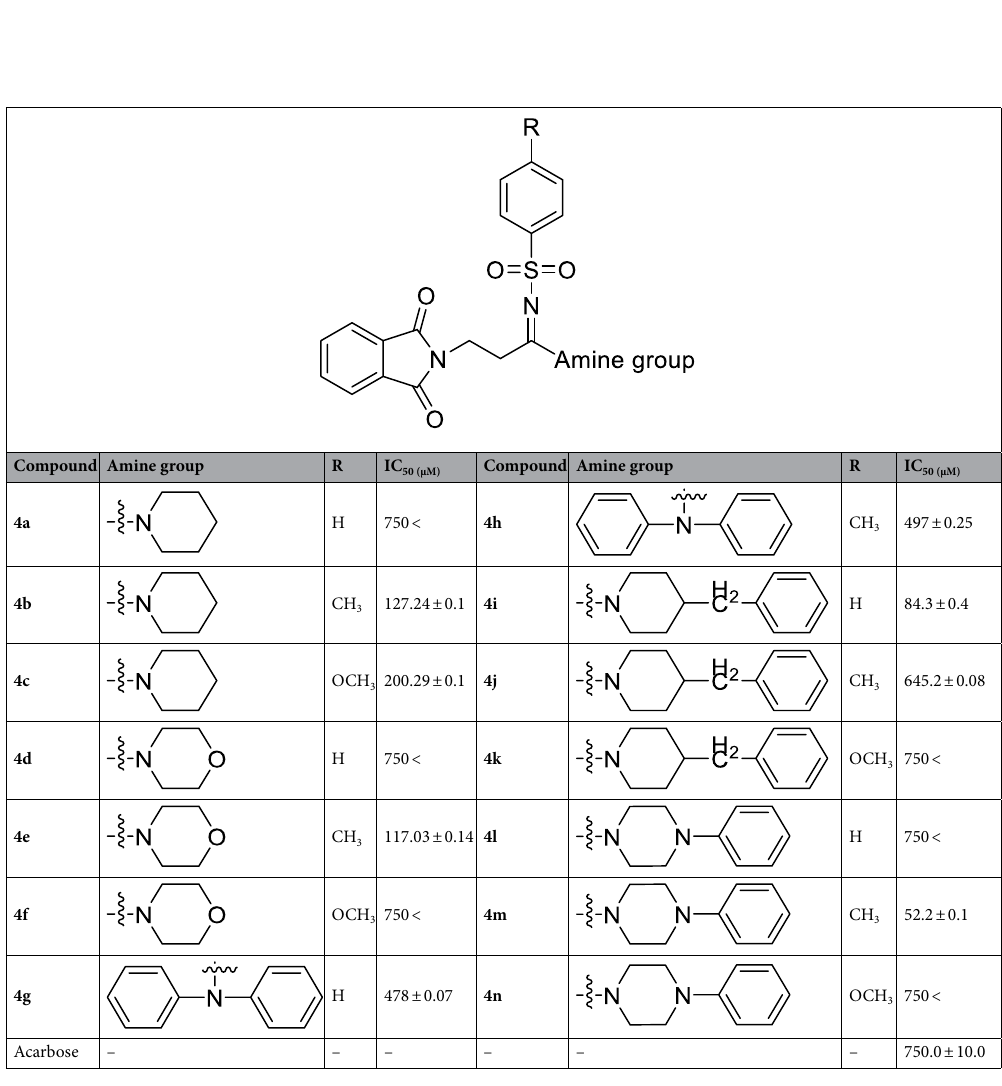
Table 1. In vitro α -glucosidase inhibitory activity of compounds 4a – n .